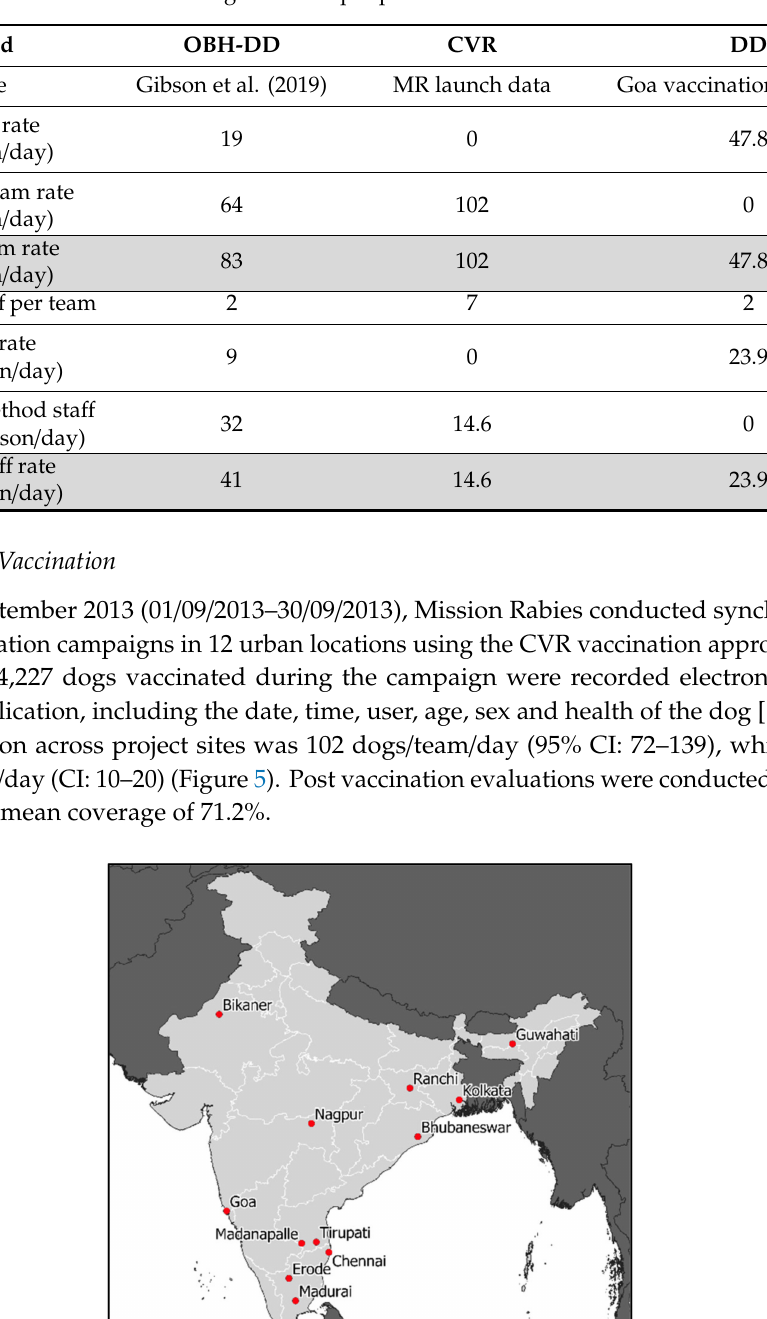
Table 2. Calculations for estimating team and per person rate of vaccination for di ff erent methods.